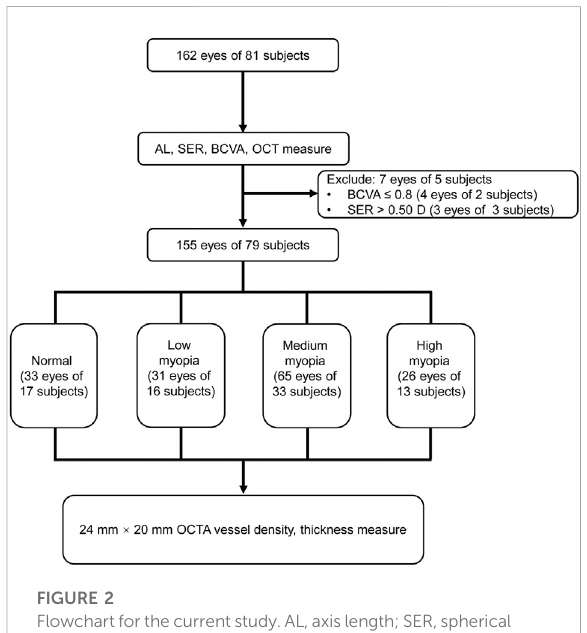
FIGURE 2 Flowchartforthecurrentstudy.AL,axislength;SER,spherical equivalent refraction; BCVA, best-corrected visual acuity; OCT, optical coherence tomography; and OCTA, optical coherence tomography